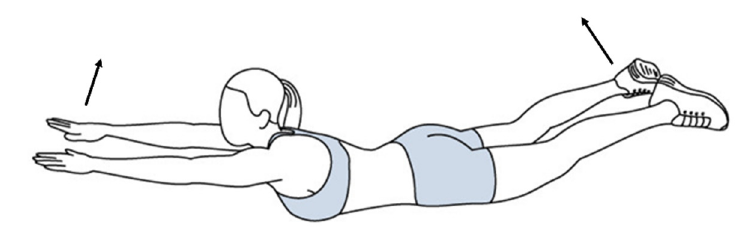
Figure 4. Dynamic Figure 4. Dynamic pose .